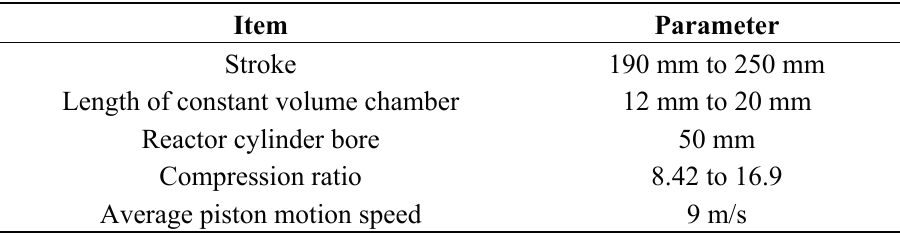
Table 1. Main parameters of the rapid compression machine